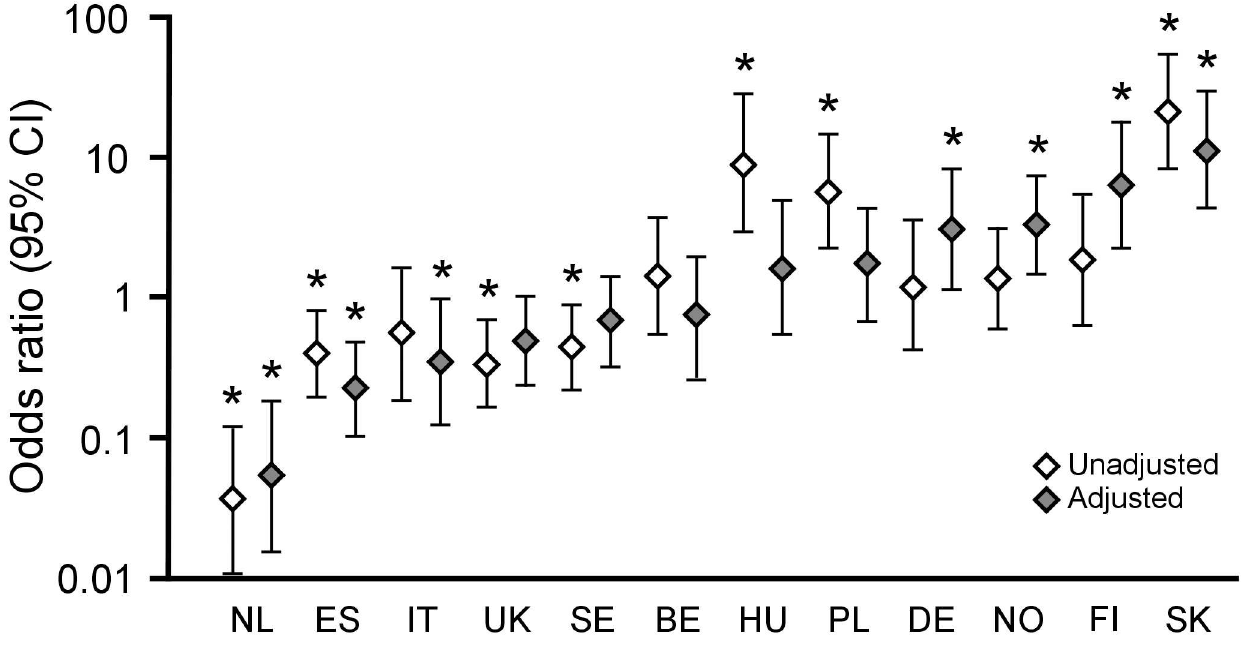
Fig 2. Unadjusted and adjusted odds ratios for FPs advice to take time off work for LRTI by network. Country as a predictor was evaluated with the clinical variables(presented in Table 4) and was included in the multivariable logistic regressionwith family practitioners fitted as random effect. * P <